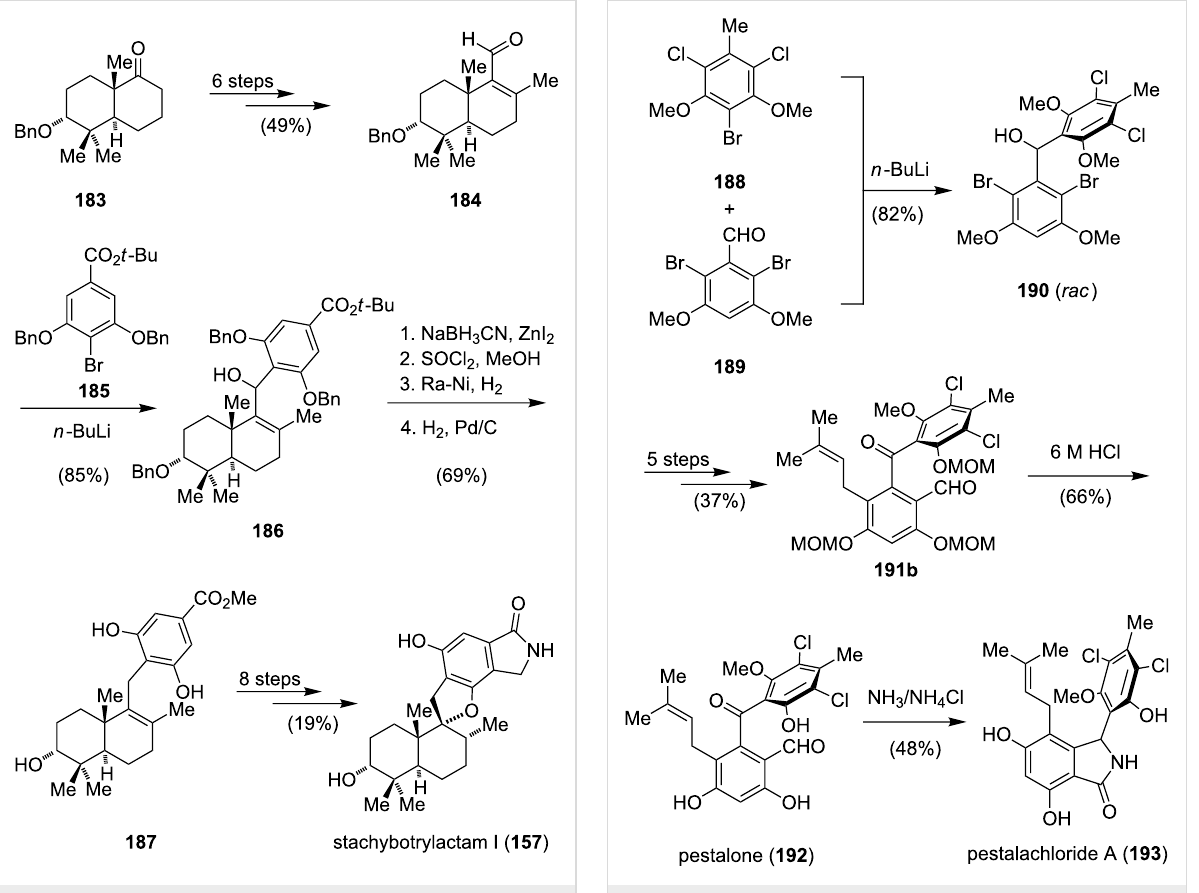
Scheme 23: Synthesis of stachybotrylactam I ( 157 ). Scheme 24: Synthesis of pestalachloride A ( 193 ) by